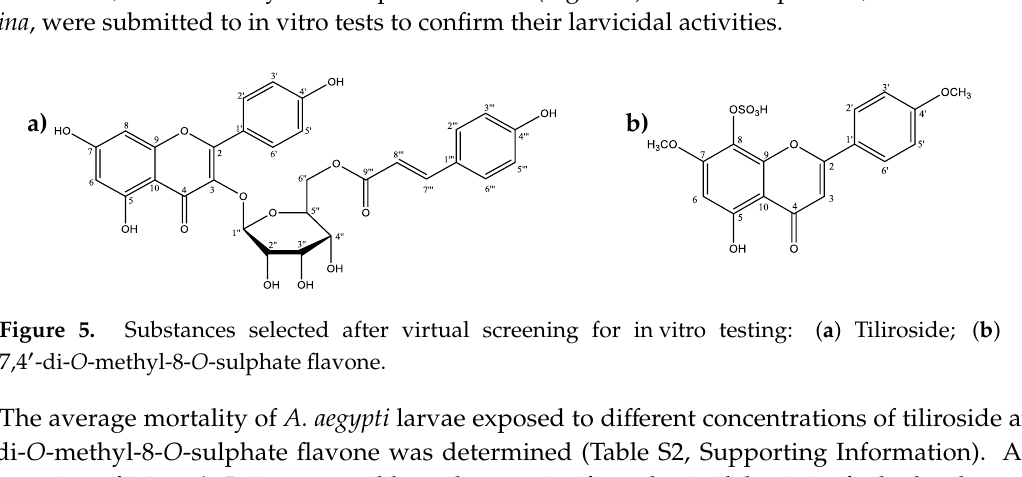
Figure 5. Substances selected after virtual screening for in vitro testing: ( a ) Tiliroside; ( b ) 7,4′-di- O - methyl-8- O -sulphate flavone .